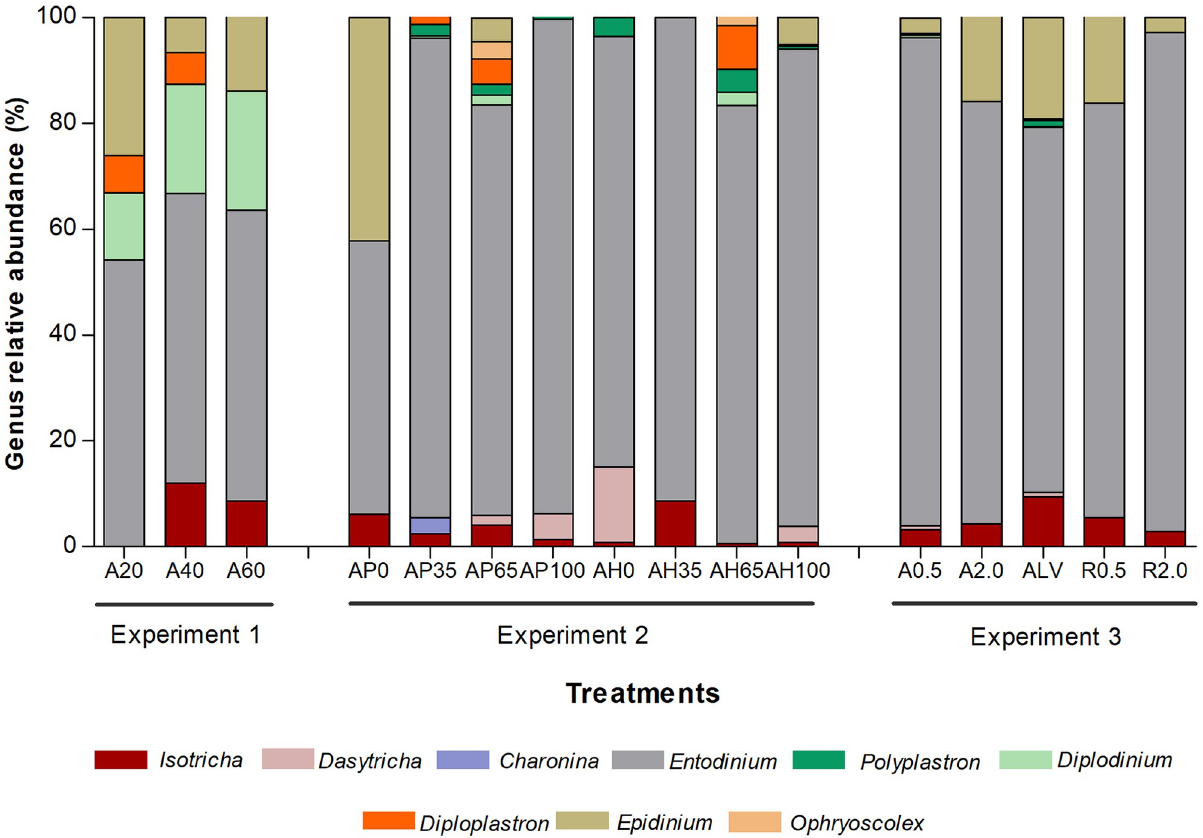
Fig 2. Relative abundance of each ciliate genus. Relative abundances for each ciliate genus identified in the 86 lambs rumen samples grouped by treatments and by experiments.